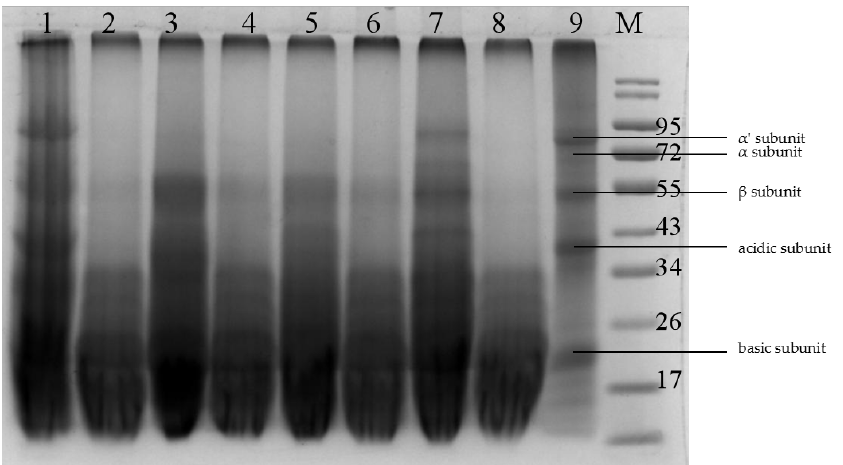
Figure 1. Protein electrophoresis analysis of SBM and FSBM produced by different strains. Lane 1, GYL1 fermented SBM; lane 2, GYL2 fermented SBM; lane 3, CICC21237 fermented SBM; lane 4, GYL3 fermented SBM; lane 5, GYL4 fermented SBM; lane 6, BSD2 fermented SBM; lane 7, GYL5 fermented SBM; lane 8, GYL6 fermented SBM; lane 9, unfermented SBM; M, protein molecular weight marker.